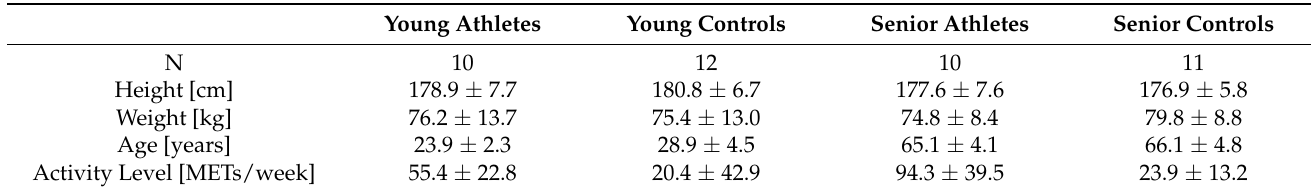
Table 1. Participants characteristics.